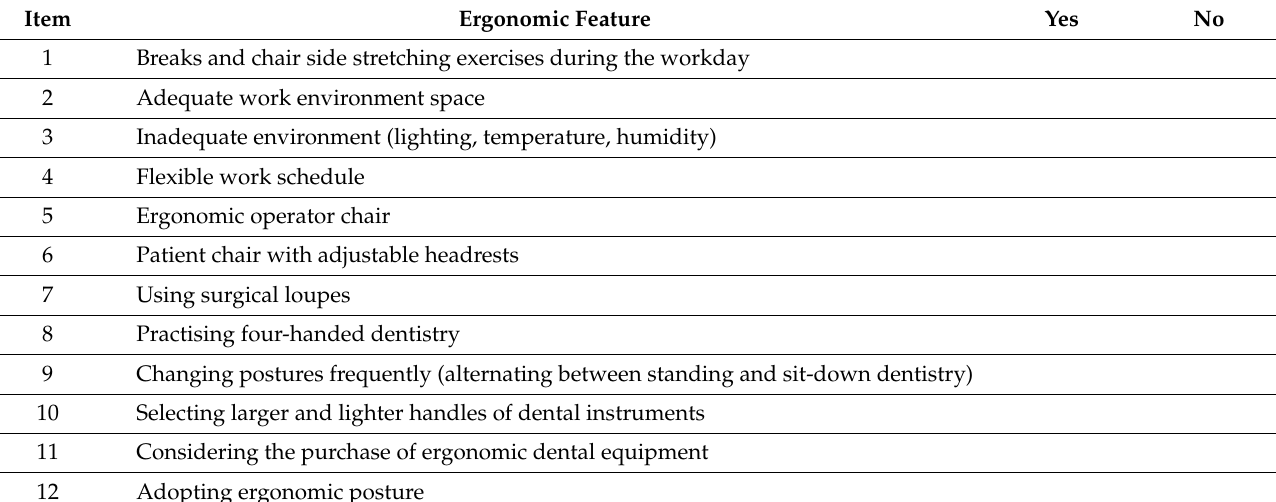
Table 2. Ergonomic checklist for dental